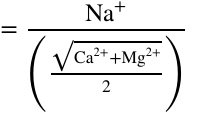
Table 8 Irrigation quality parameters for groundwater